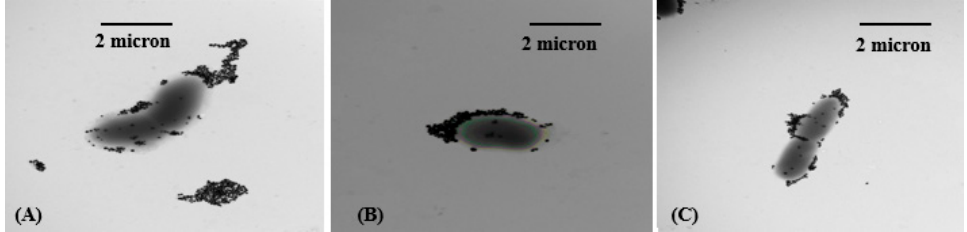
Figure 11. Representative TEM images of ( A ) E. coli ( B ) P. aeruginosa ( C ) S. enterica after treatment with spherical silver nanoparticles coated with poly-Arg-PVP.